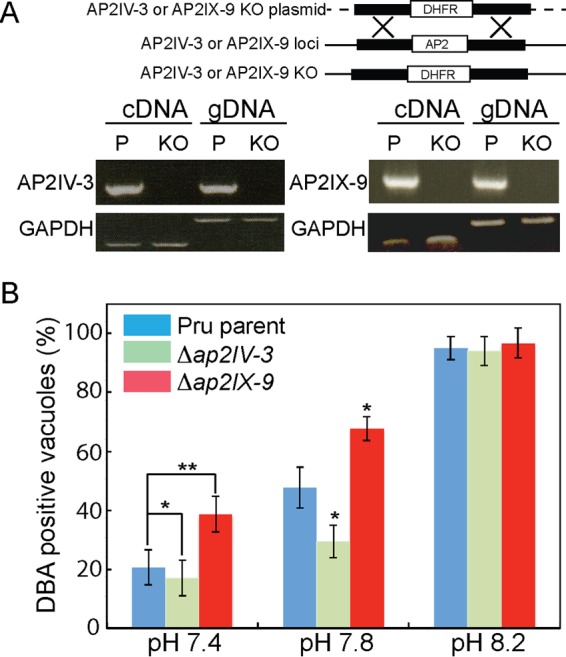
Disruption of the AP2IV-3 and AP2IX-9 genes alters the capacity to form tissue cysts. (A) Schematic representation of knockout constructs for the AP2IV-3 and AP2IX-9 loci. Disruptions of AP2IV-3 and AP2IX-9 were achieved by using the pyrimethamine-resistant dihydrofolate reductase (DHFR)-selectable marker and CRISPR methodology, as shown by the PCR analysis of transgenic DNA (gDNA) and RT-qPCR of cDNA of the parent (P) and knockout (KO) strains. Proper fragment sizes: cDNA, 202 bp; gDNA, 634 bp. PCR analysis of GAPDH was included as a negative control. (B) Tissue cyst formation by the Pru parent strain versus that by Pru-Δap2IV-3 and Pru-Δap2IX-9 knockout parasites grown under different alkaline stress conditions. The proportion of DBA-positive vacuoles in 100 randomly selected vacuoles was assayed in triplicate. Note that disruption of AP2IX-9 (red bars) led to greater tissue cyst formation under milder alkaline conditions, while the opposite result was observed when the AP2IV-3 gene was deleted (green bars). The statistical significance of decreases and increases in cyst formation caused by the loss of AP2IV-3 and AP2IX-9, respectively, is indicated (*, P < 0.05; **, P < 0.01); green-versus-blue and red-versus-blue statistical comparisons, as diagramed for the pH 7.4 data, were repeated for the pH 7.8 results. No statistically significant difference in cyst formation by Pru parasite strains grown in pH 8.2 medium was observed.